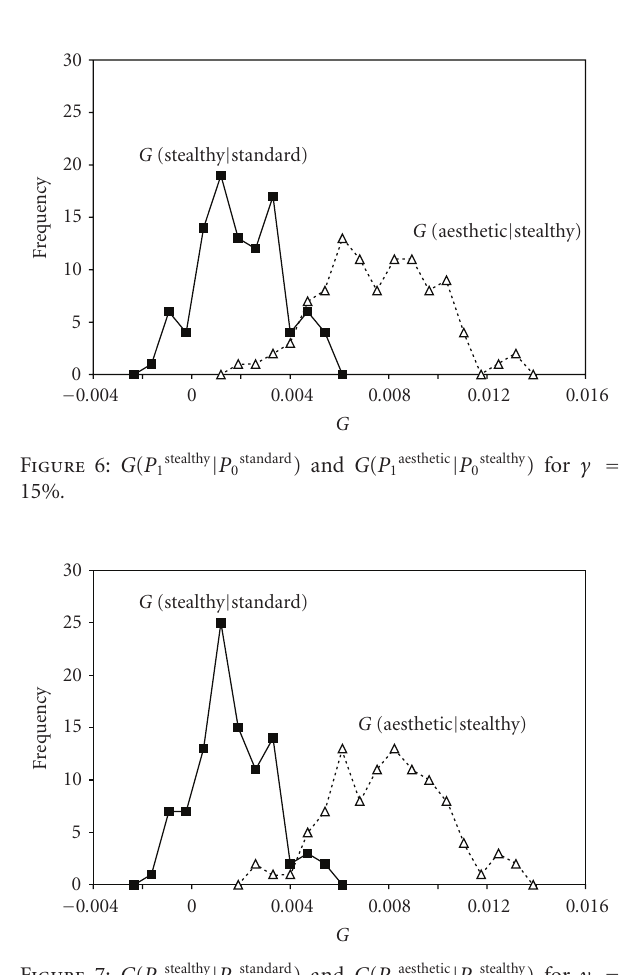
Table 3: Number of successes and failures and P -value.